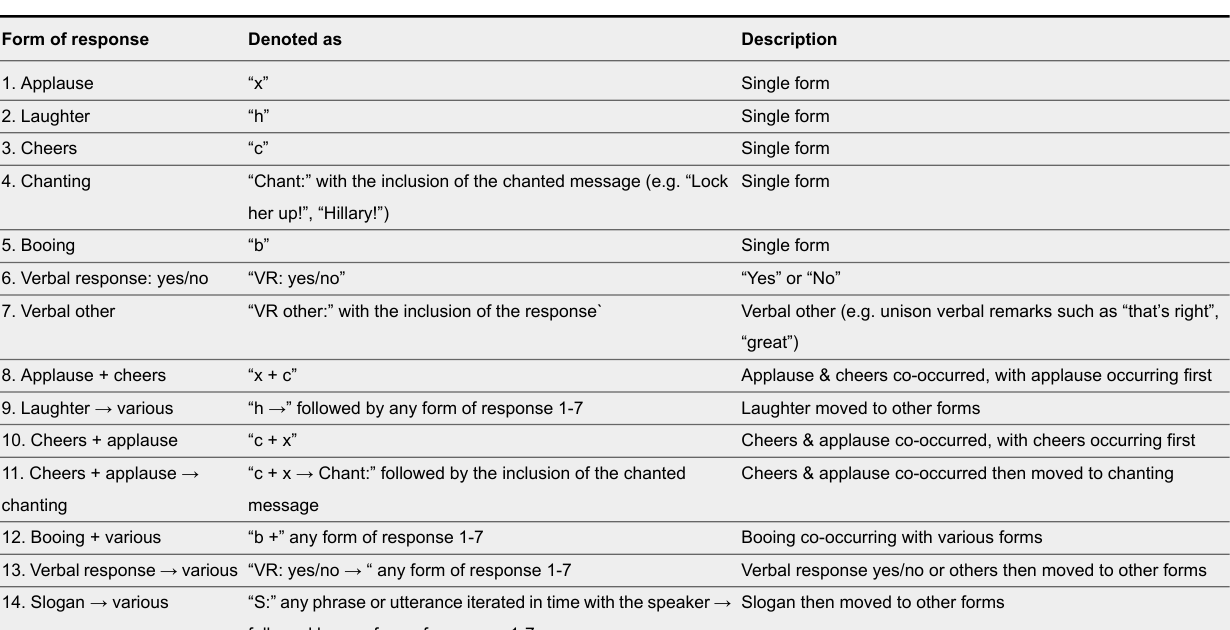
Forms of Response, With Denotations and